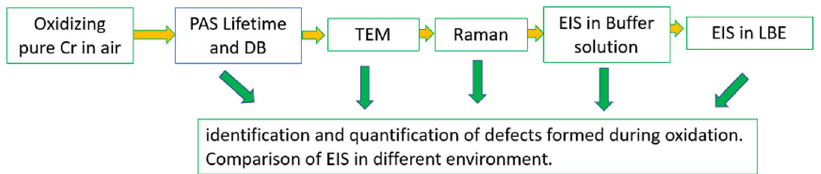
Fig. 11 Sample fl ow through the experimental procedure. The same oxidized chromium samples traveled among experimental facilities for the different characterization